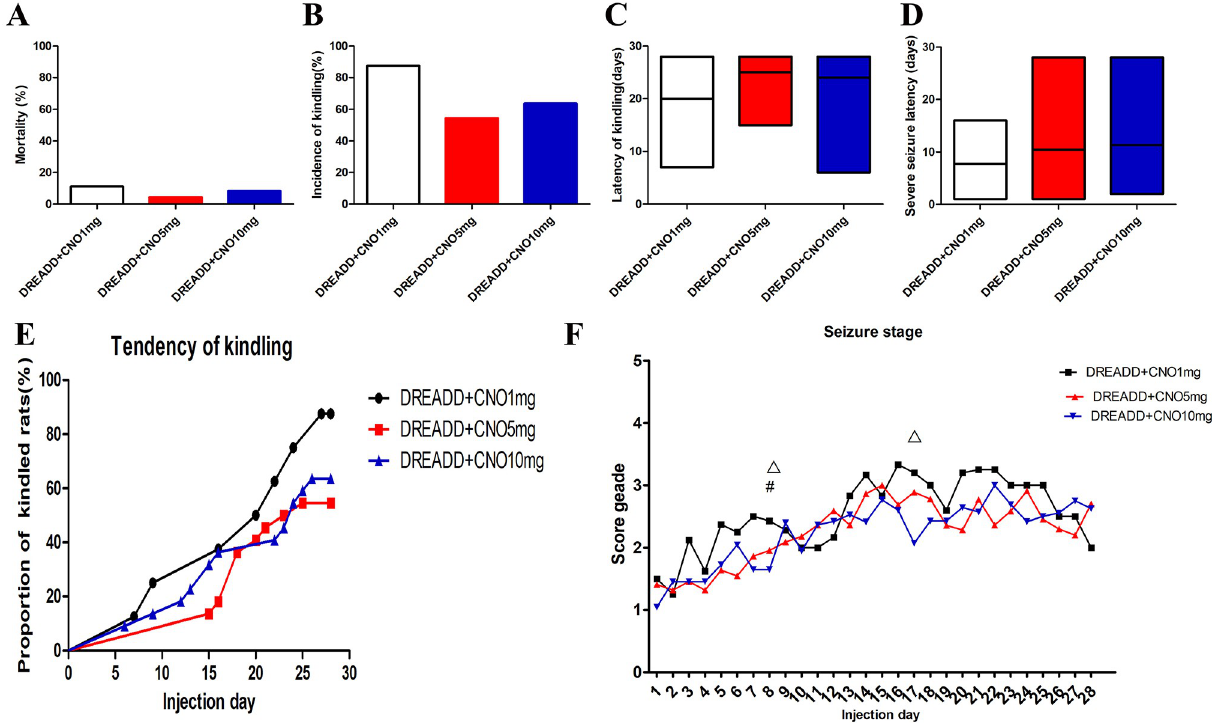
Fig 6. The effect of multiple CNO doses on epileptogenesis in PTZ kindling rat model infected with hM4Di DREADD in DG. Mortality(A), kindling rate(B), latency of kindling(C), severe seizure latency(D), tendency of kindling(E) and seizure stage(F) of DREADD rats with CNO at 1 mg/kg, 5mg/kg and 10 mg/kg. CNO, clozapine N-oxide; DG, dentate gyrus. Δ indicates P < 0.05, 10mg/kg CNO vs 1mg/kg CNO; # indicates P < 0.05, 5mg/kg CNO vs 1mg/kg CNO.